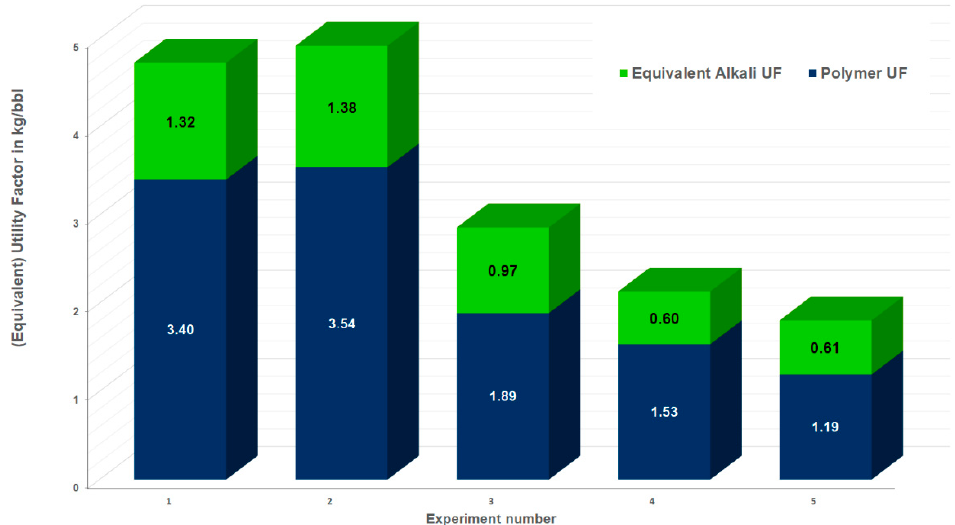
Figure 18. Equivalent utility factor (EqUF) for the experiments. The EqUF shown here reflects the incremental oil produced by the alkali–polymer slug and the mass of chemicals injected during this slug, assuming 1 PV injection. The polymer EqUF is the part of the overall EqUF related to the mass of the polymer injected during the injection of the AP slug, whereas the alkali EqUF reflects the cost-normalized mass of the alkali injected during the AP slug injection.